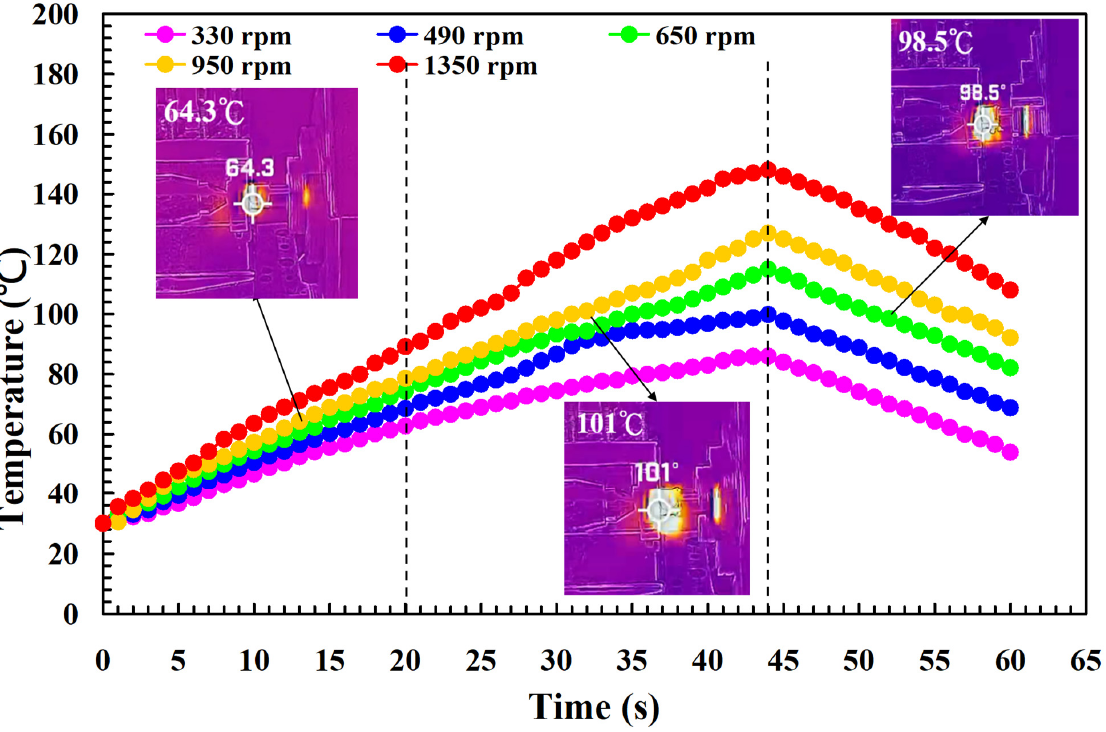
Figure 9. The relationship between weld-joint temperature and FW time for the PLA and PLA filled with CF rods at five different rotational speeds.